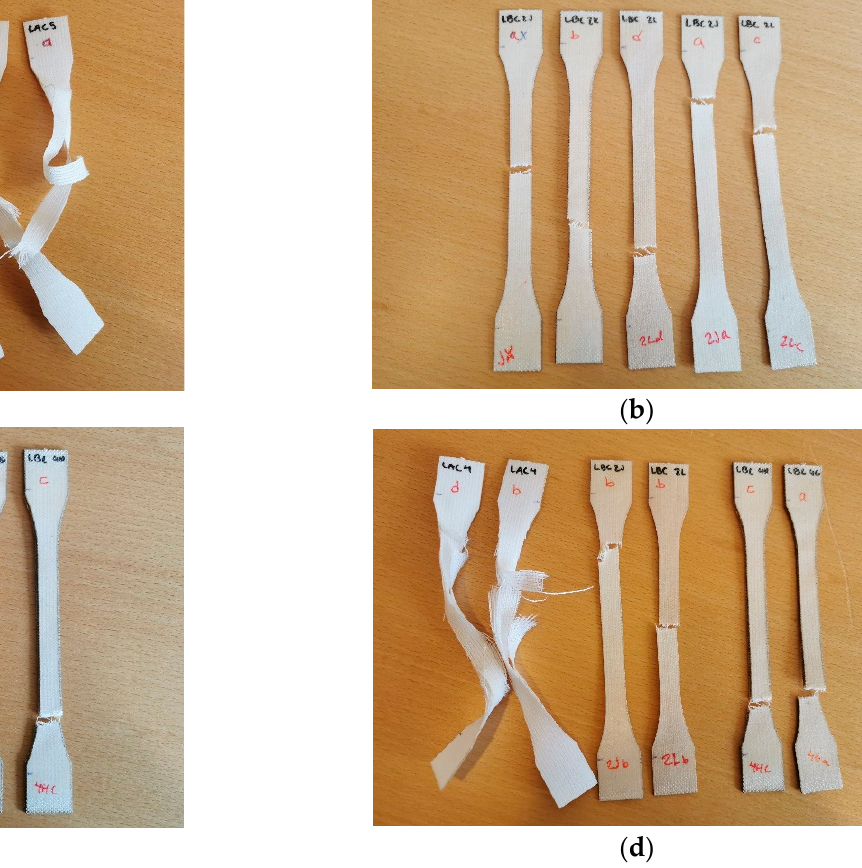
Figure 4. Broken dumbbell tensile test samples. Test samples of L-ACC are seen in ( a ), L-BC2 in ( b ) and L-BC4 in ( c ), and two of each sample category in the same order are seen in image ( d ).